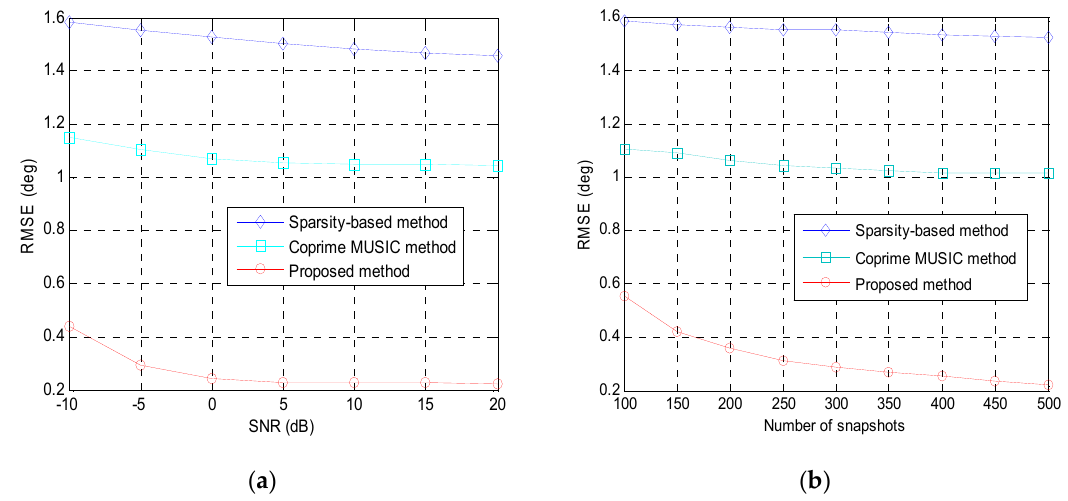
Figure 5. The RMSE performance of the tested methods when there are more sources than the physical sensors: ( a ) RMSE versus the input SNR; ( b ) RMSE versus the number of snapshots; fourth example.